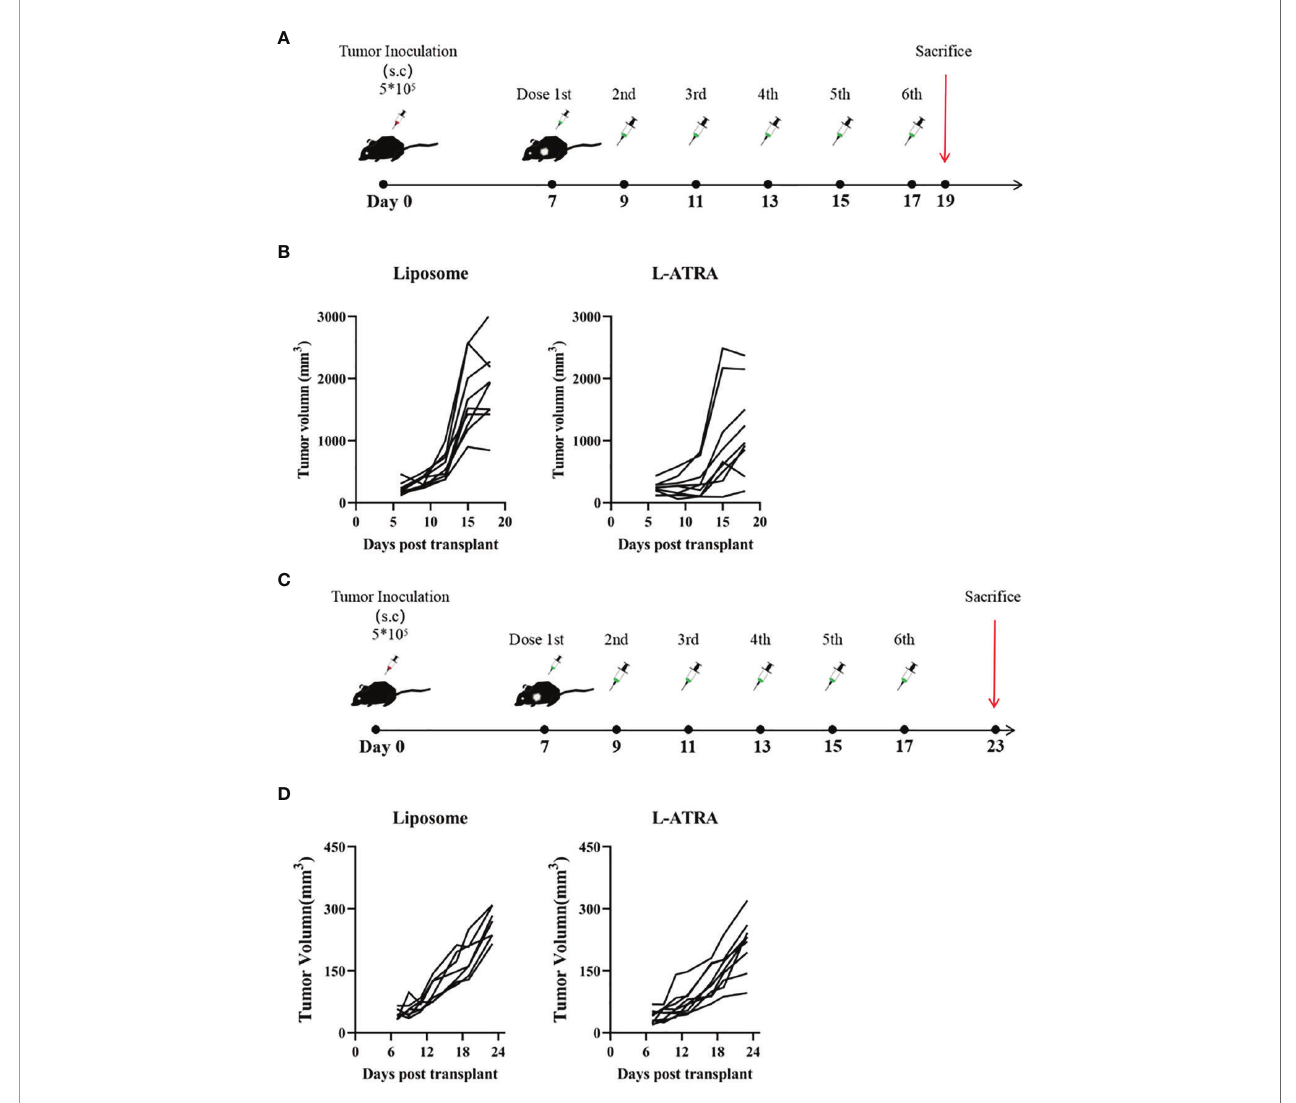
FIGURE 4 | The tumor growth inhibition effect of L-ATRA in Syngeneic CT26 mouse colorectal cancer mice or A549 human lung cancer xenograft mice. (A) Syngeneic mice bearing CT26 mouse colorectal cancer were treated with L-ATRA every other day; (B) Tumor volume from each individual mice treated with either liposomes (left) or L-ATRA(right). (C) Nude mice bearing A549 human lung cancer received injections every other day for a total of 6 doses; (D) Tumor volume from each individual